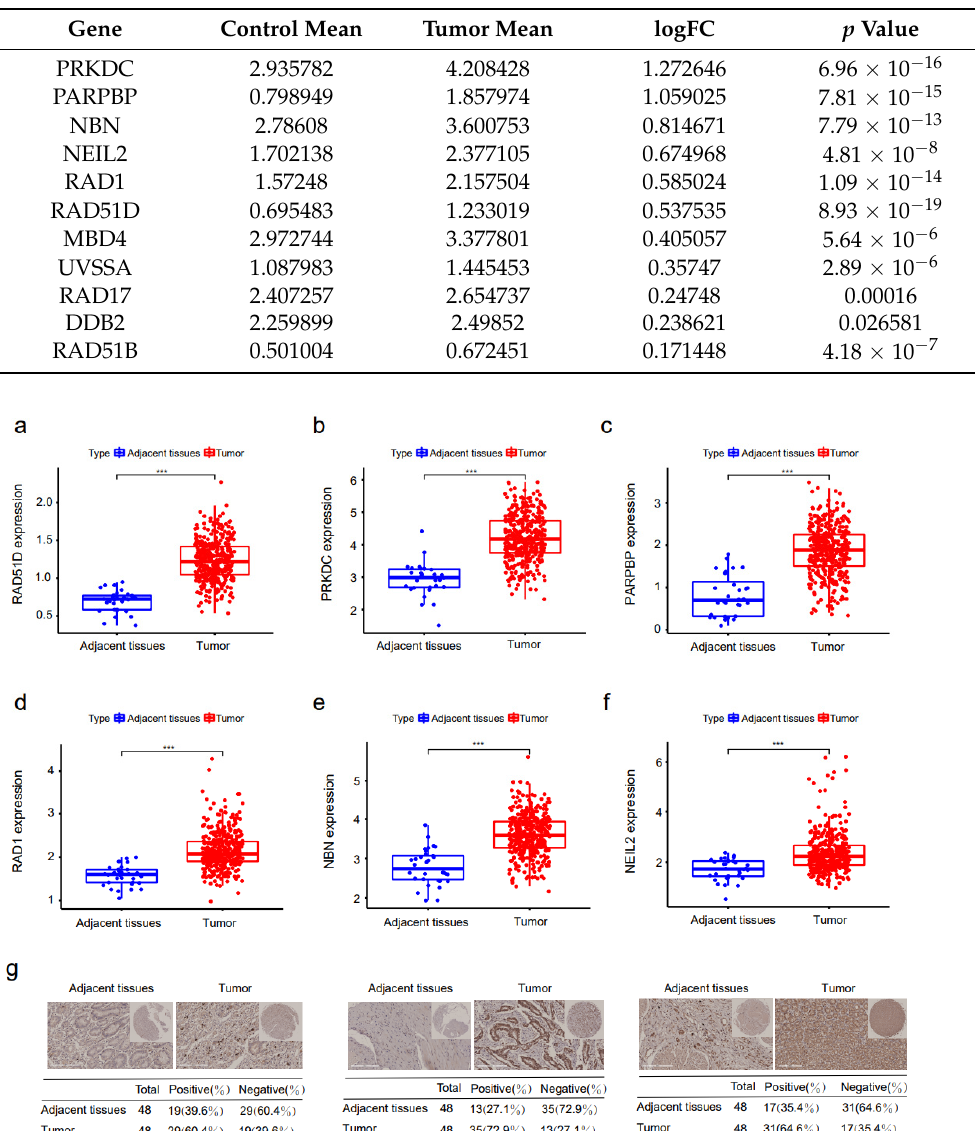
Table 2. Differentially expressed DNA repair genes whose PSI value of their alternative splicing events is related to the overall survival of STAD patients.